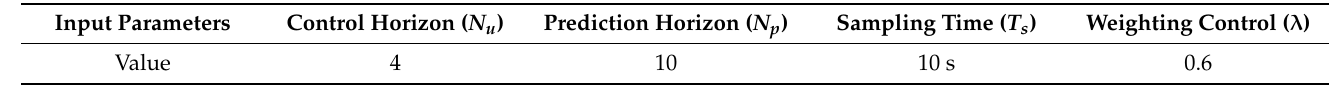
Table 1. GPC algorithms’ input